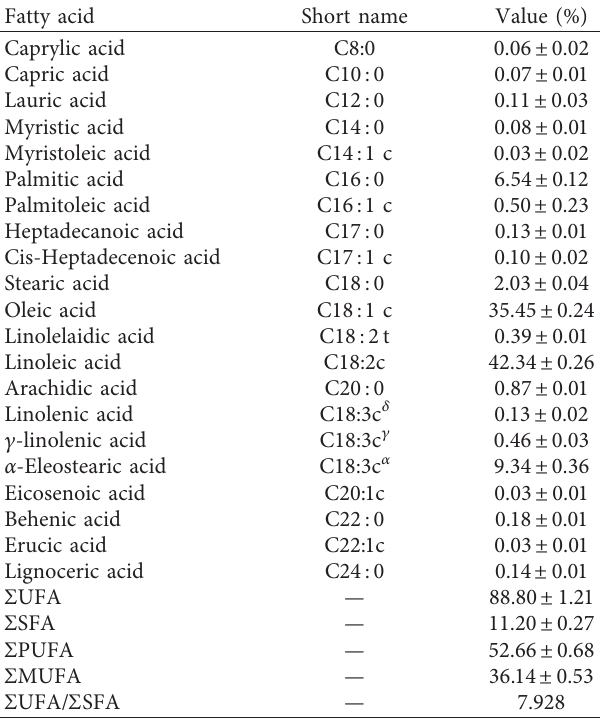
Table 2: Fatty acid composition of sour cherry kernel